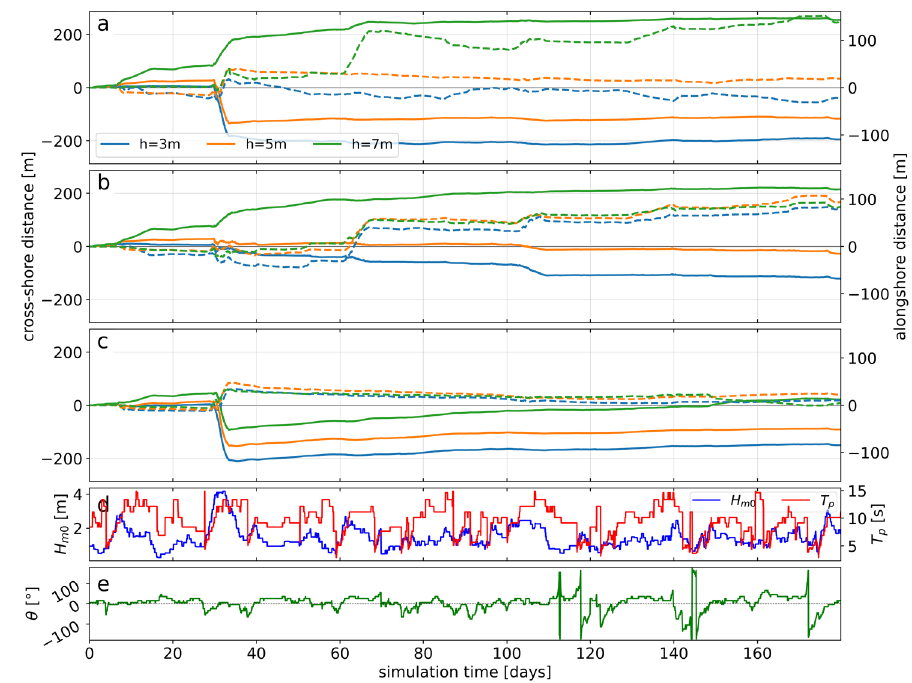
Figure 20. Time series of cross-shore (solid line) and alongshore (dashed lines) displacements of nearshore nourishment sediment for the Vilano Beach scenario for 3 m (blue lines), 5 m (orange lines), and 7 m (green) placement depths, respectively. ( a ) Linear berm; ( b ) undulated berm; ( c ) discrete mounds; ( d ) offshore wave height and peak period; ( e ) wave direction relative to shore-normal.